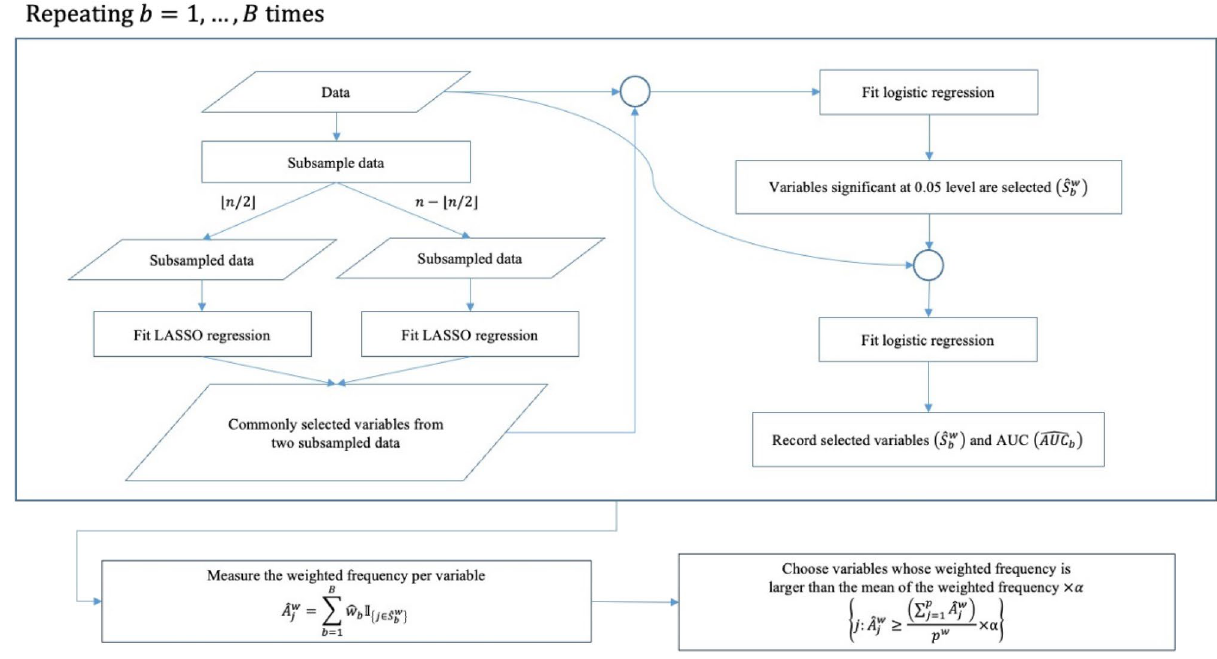
Figure 1. The whole process of weighted stability